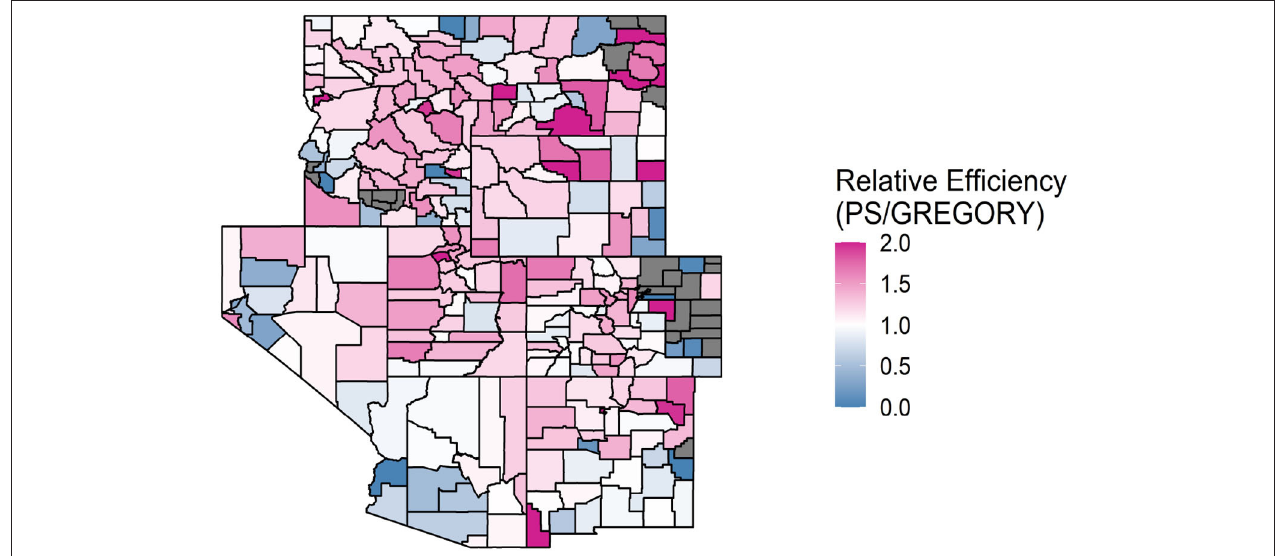
FIGURE 2 | A map of the relative efficiencies of the PS to the GREGORY when estimating the average trees per acre for each county in the Interior West. Values above 1 indicate that the GREGORY is more efficient. Values greater than 2 were truncated to 2 to increase the readability of the map. A county is gray if the RE is 0, due to all plots containing values of 0 trees per acre.